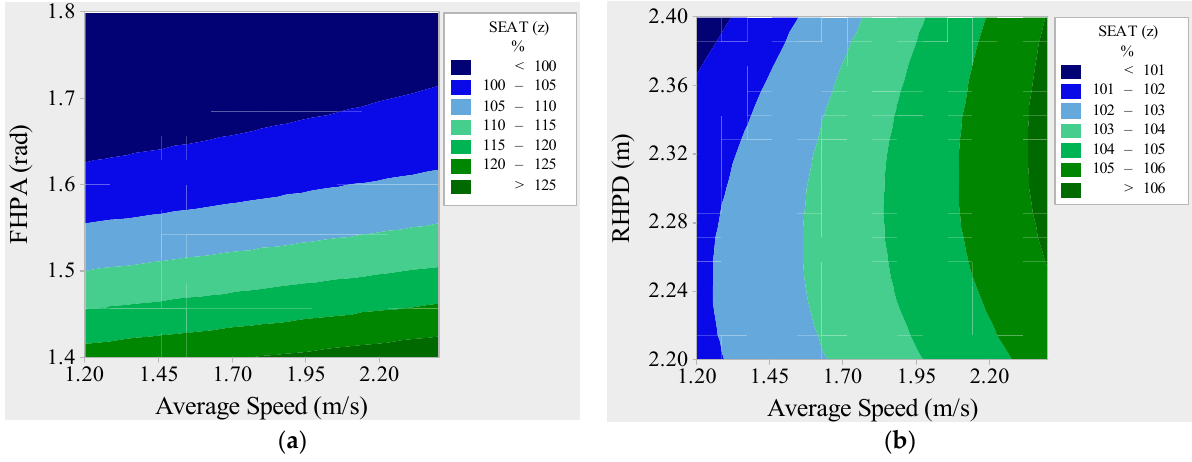
Figure 7. Effect on SEAT% with respect to ( a ) FHPA and average speed; ( b ) RHPD and average speed.